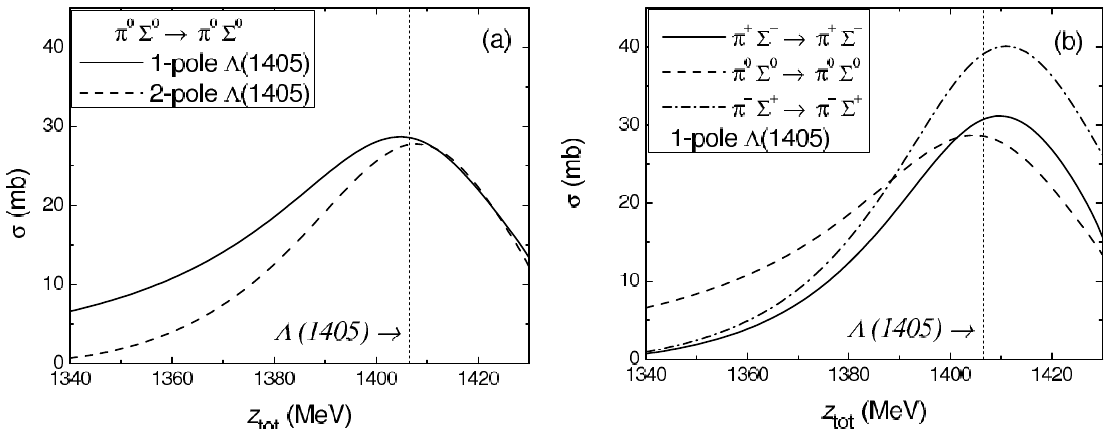
Fig. 1. The calculated pi-Sigma elastic cross-sections in di ff erent charge channels: (a) π 0 Σ 0 (proportional to purely I = 0) cross-sections given by the one-pole and two-pole Λ (1405) potentials, (b) three charge channel cross-sections for the one-pole potential. The vertical line marks the medium PDG mass M PDG = 1406 . 5 MeV of the resonance [12]. Λ